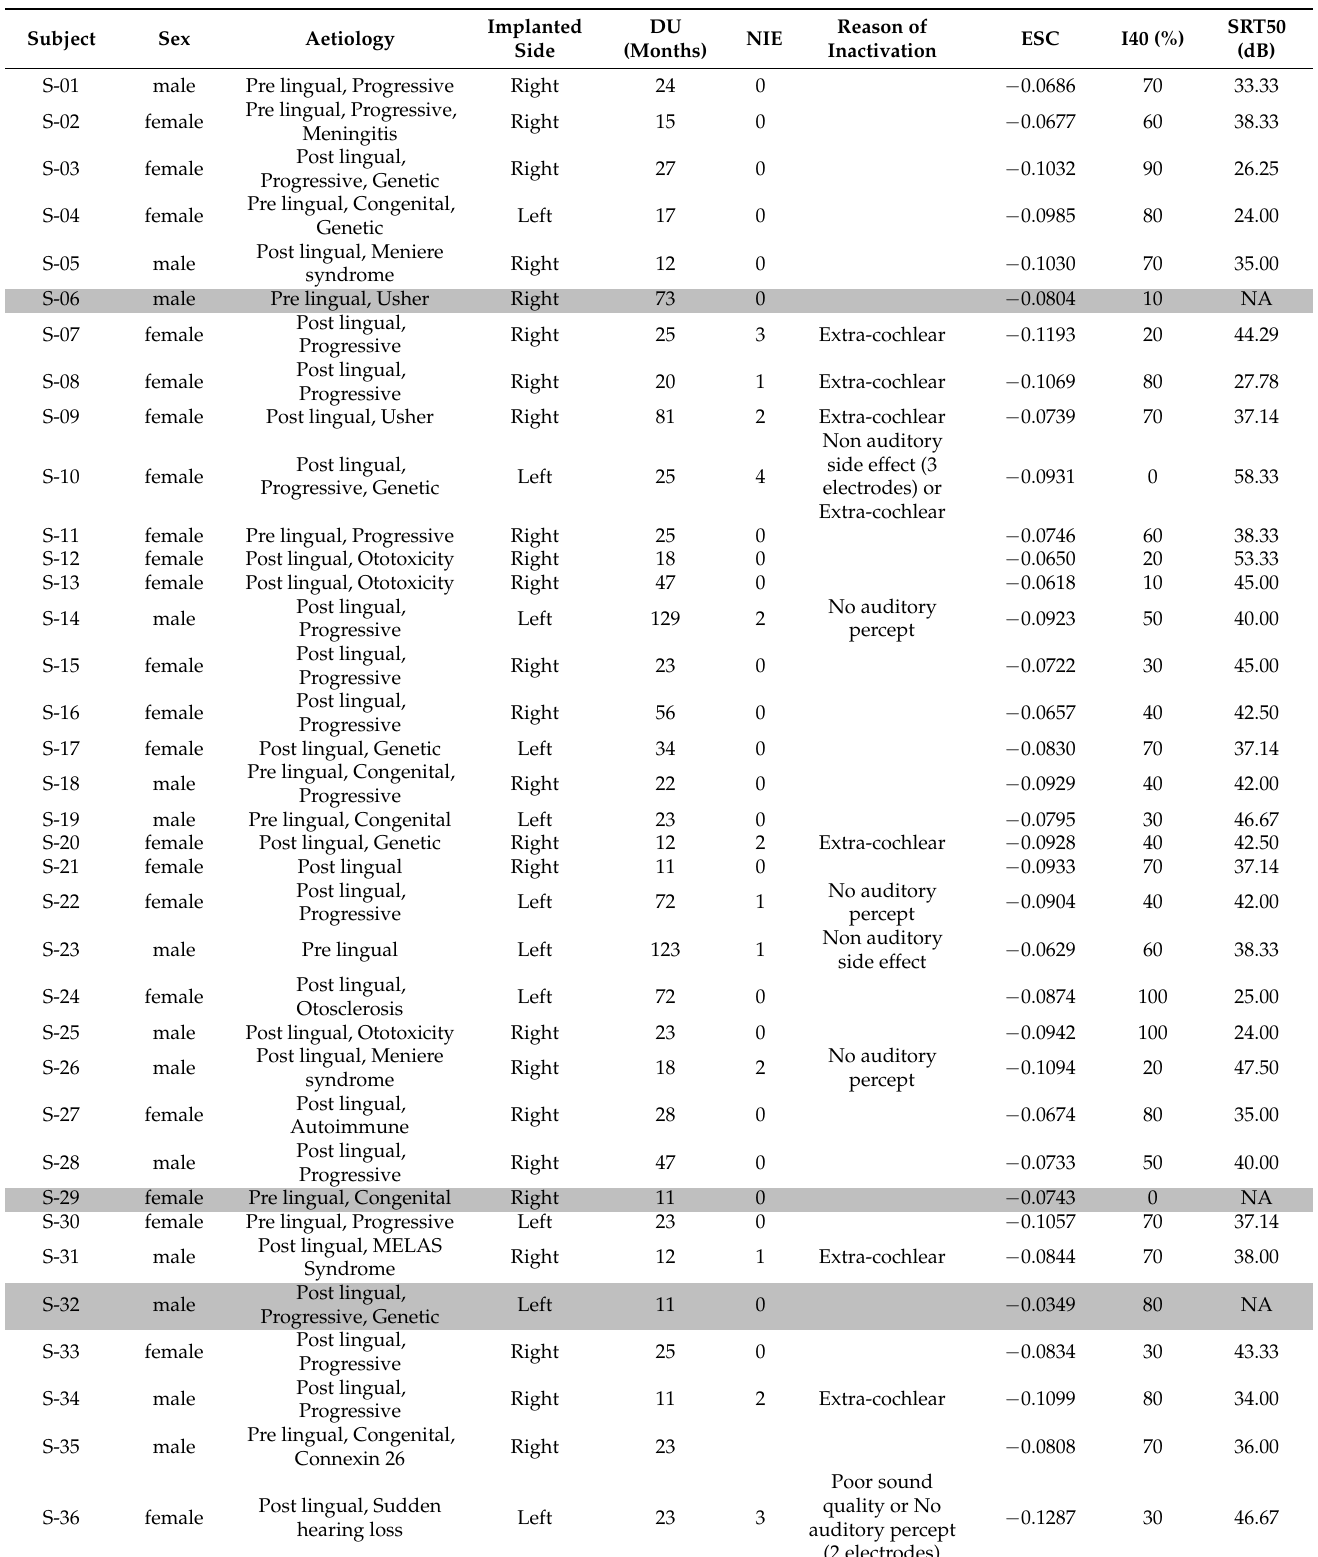
Table 1. Subjects’ characteristics and characteristic values (DU: Duration of CI use, NIE: Number of inactivated electrodes, ESC: Exponential spread coefficient, I40: Intelligibility at 40 dB HL, SRT50: 50% Speech reception threshold—Grey background: no computable